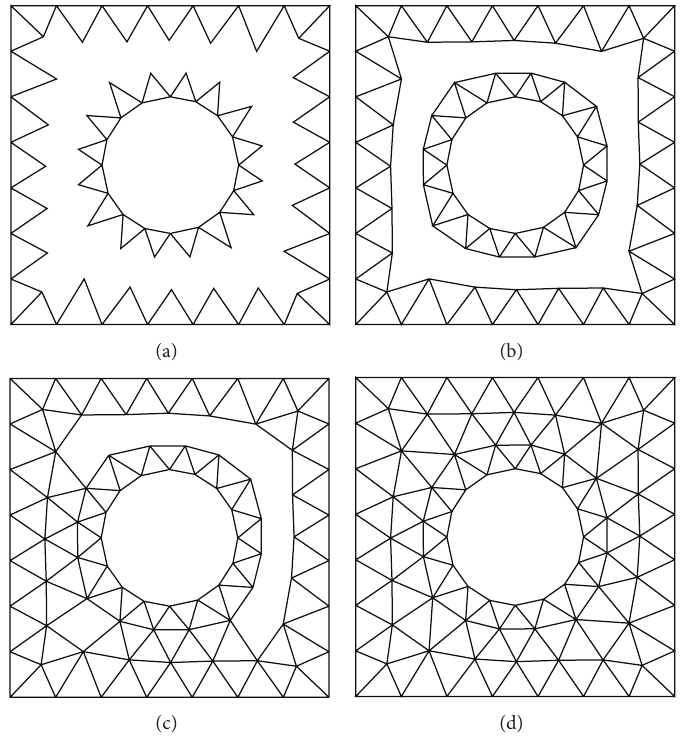
Figure 1: The AFT for generating planar